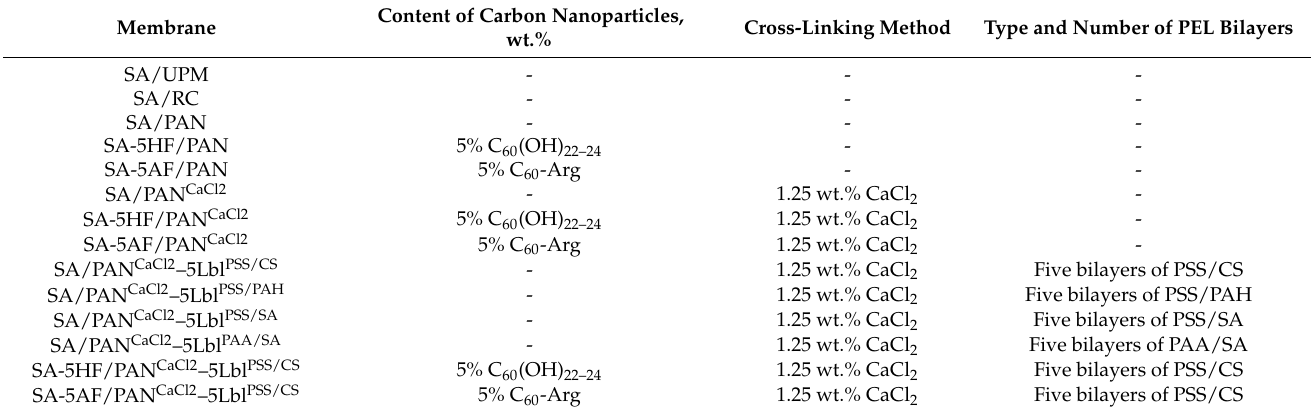
Table 1. Developed supported sodium alginate (SA)-based